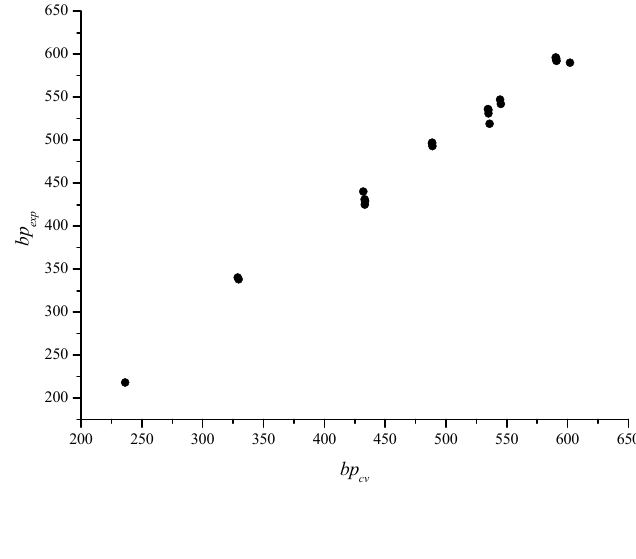
Figure 8. Scatter plots of fit residuals versus fitted values ( bp residuals versus cross validated values ( bp